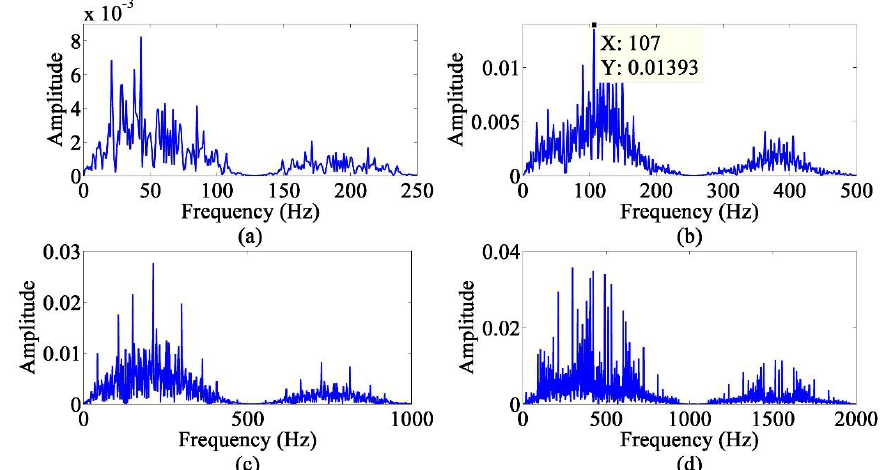
Figure 11. The amplitude spectra of each component after six-layer wavelet decomposition. ( a ) The sixth layer of the low-frequency component. ( b ) The sixth layer of the high-frequency component. ( c ) The fifth layer of the high-frequency component. ( d ) The fourth layer of the high-frequency component.